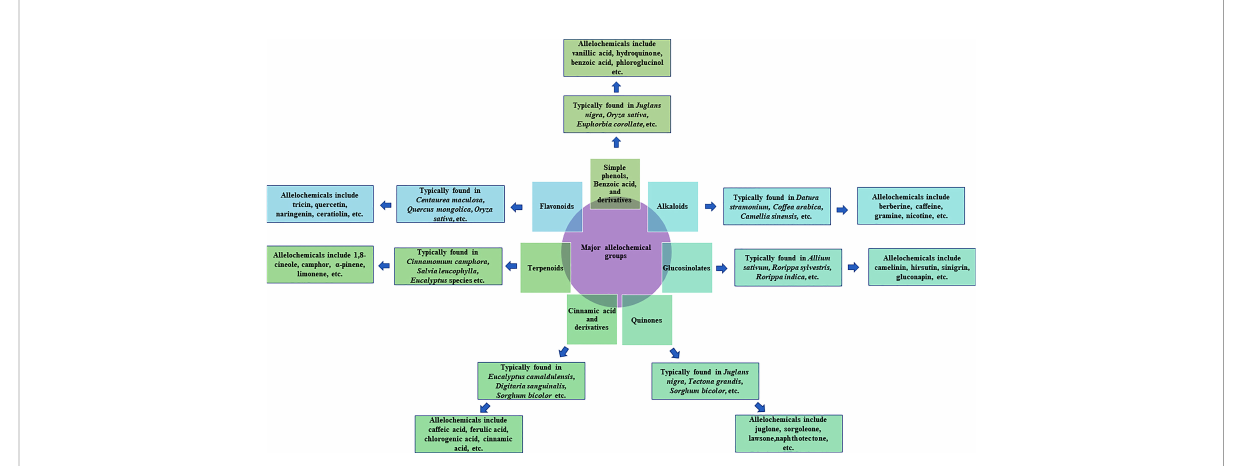
FIGURE 2 Selected seven allelochemicals from the 14 categories, their sources, and the allelochemicals present in